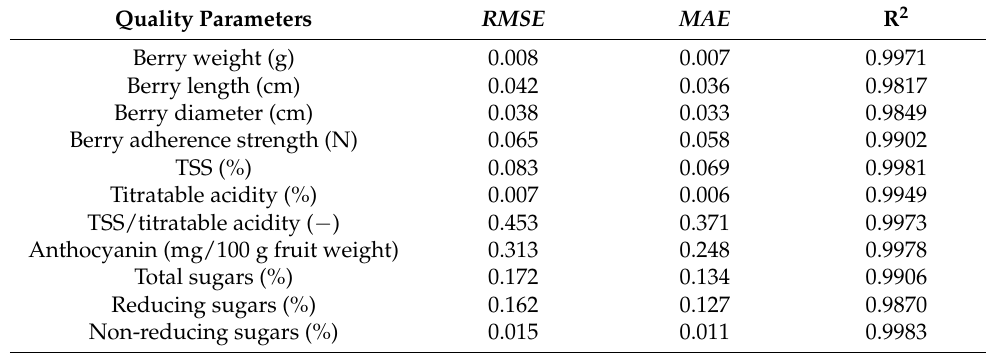
Table 5. RMSE and MAE values and R 2 for each quality parameters predictions of Flame Seedless grapes berries using ANN model with a 3-20-11 topology and testing set. Quality